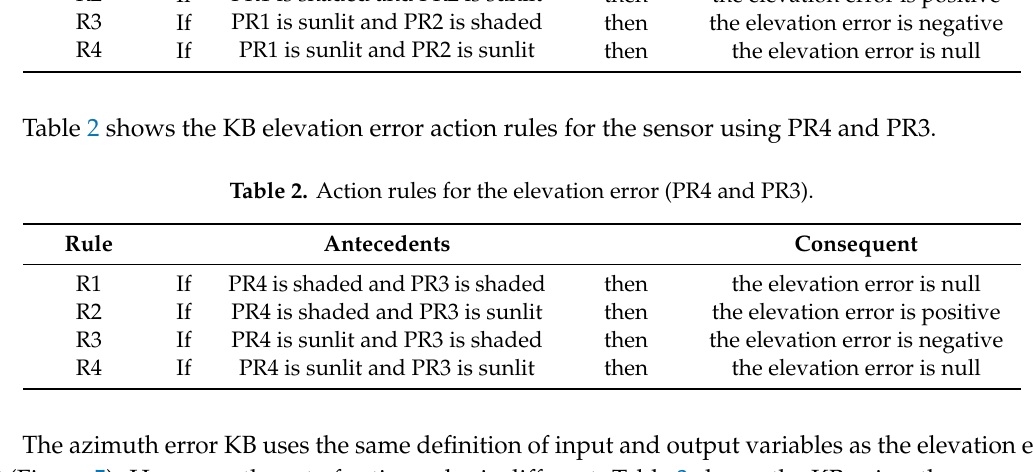
Table 3. Action rules for the azimuth error (PR4 and PR1).